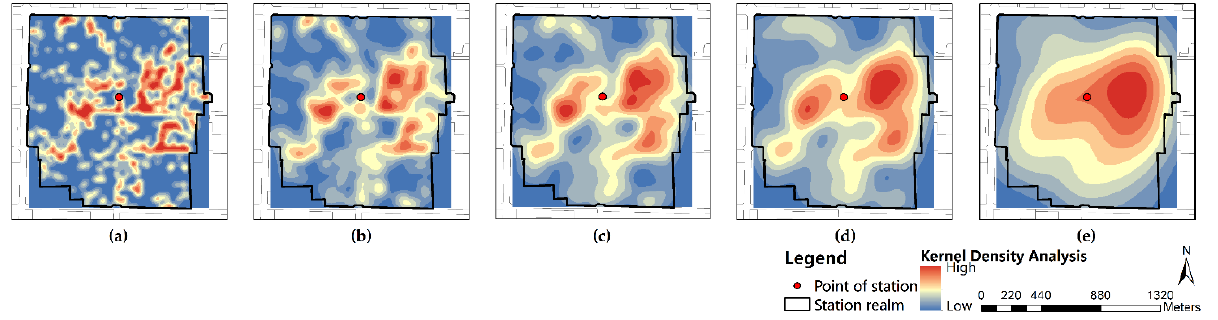
Figure 9. Visualization of kernel density analysis results under different scale search radius: ( a ) 50 m radius, ( b ) 100 m radius, ( c ) 150 m radius, ( d ) 200 m radius, ( e ) more than 200 m radius.